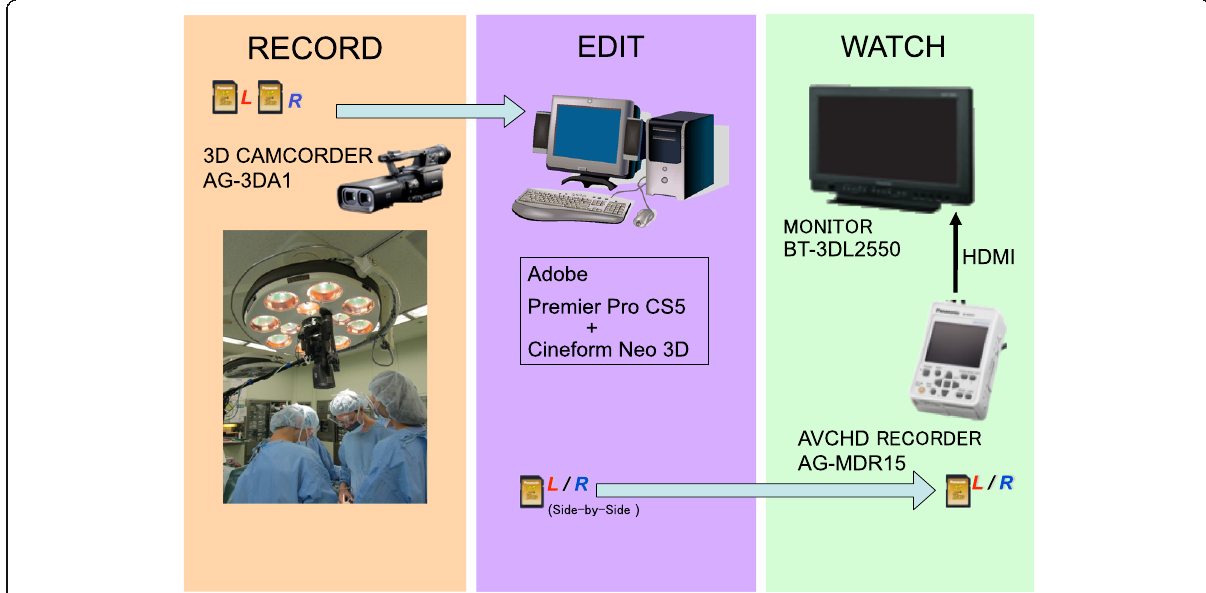
Fig. 1 Flowchart of the 3DHD movie recording, editing, and